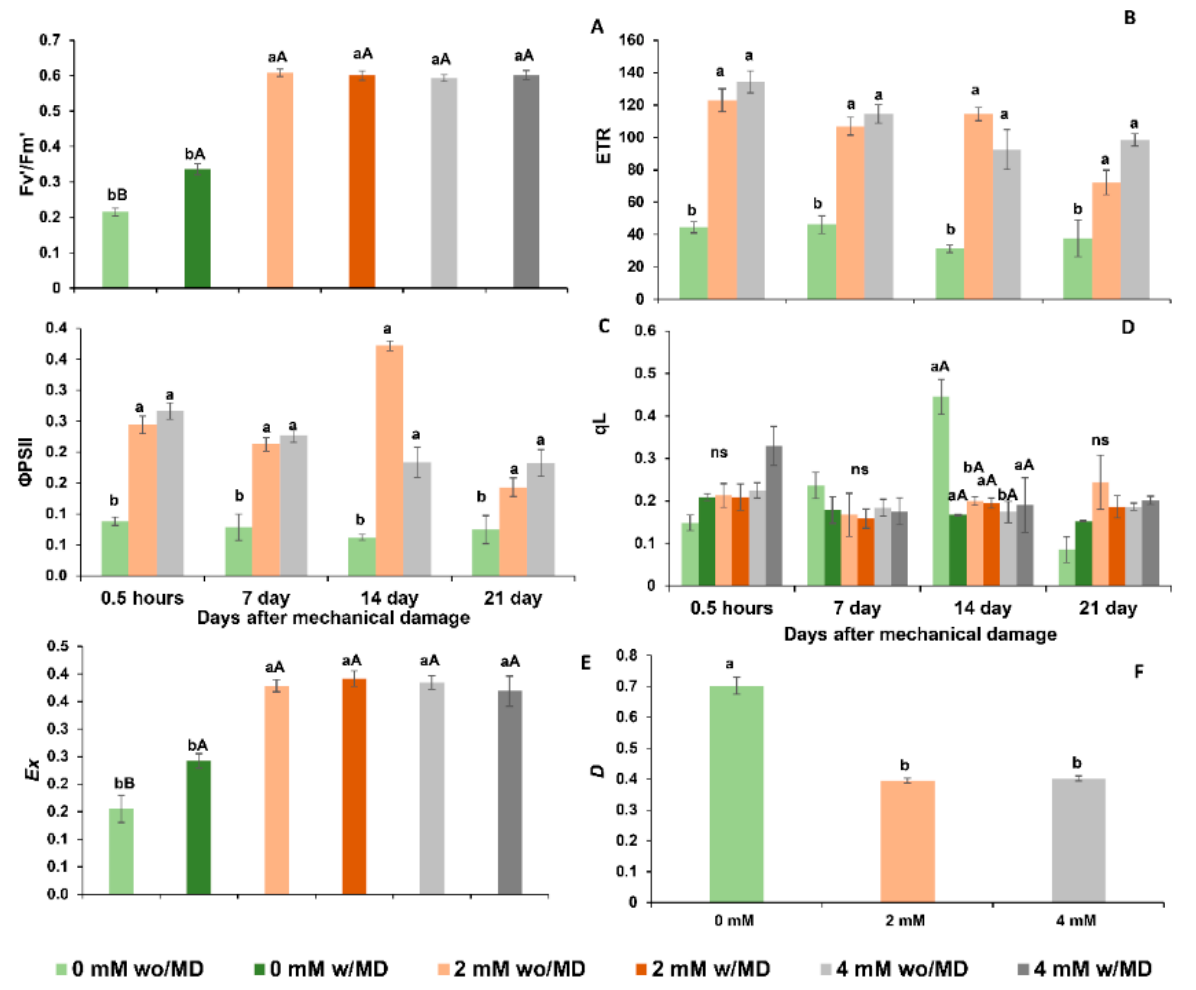
Figure 6. ( A ). Photosystem II efficiency (Fv’/Fm’) damage × calcium <0.001; ( B ). electron